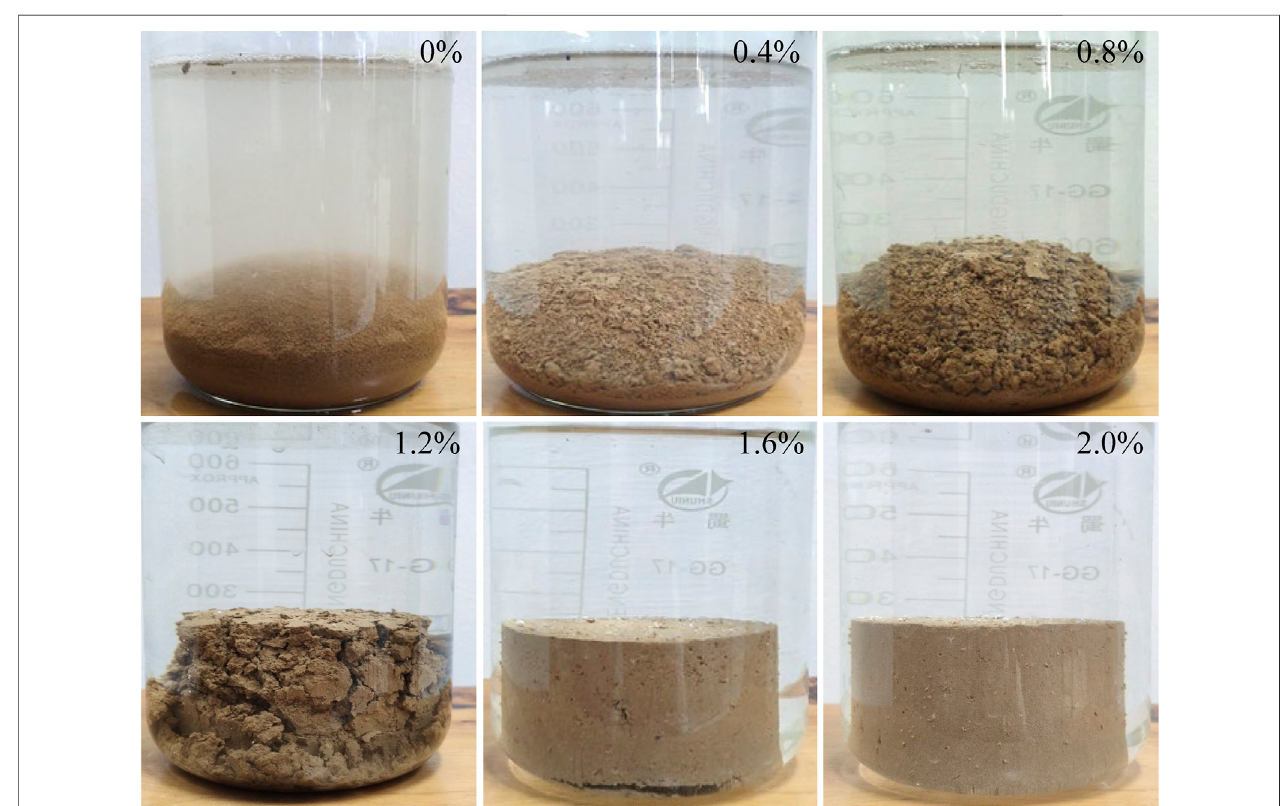
FIGURE 5 | Samples treated with different cross-linked polymer (CLP) concentrations following immersion for 24 h.